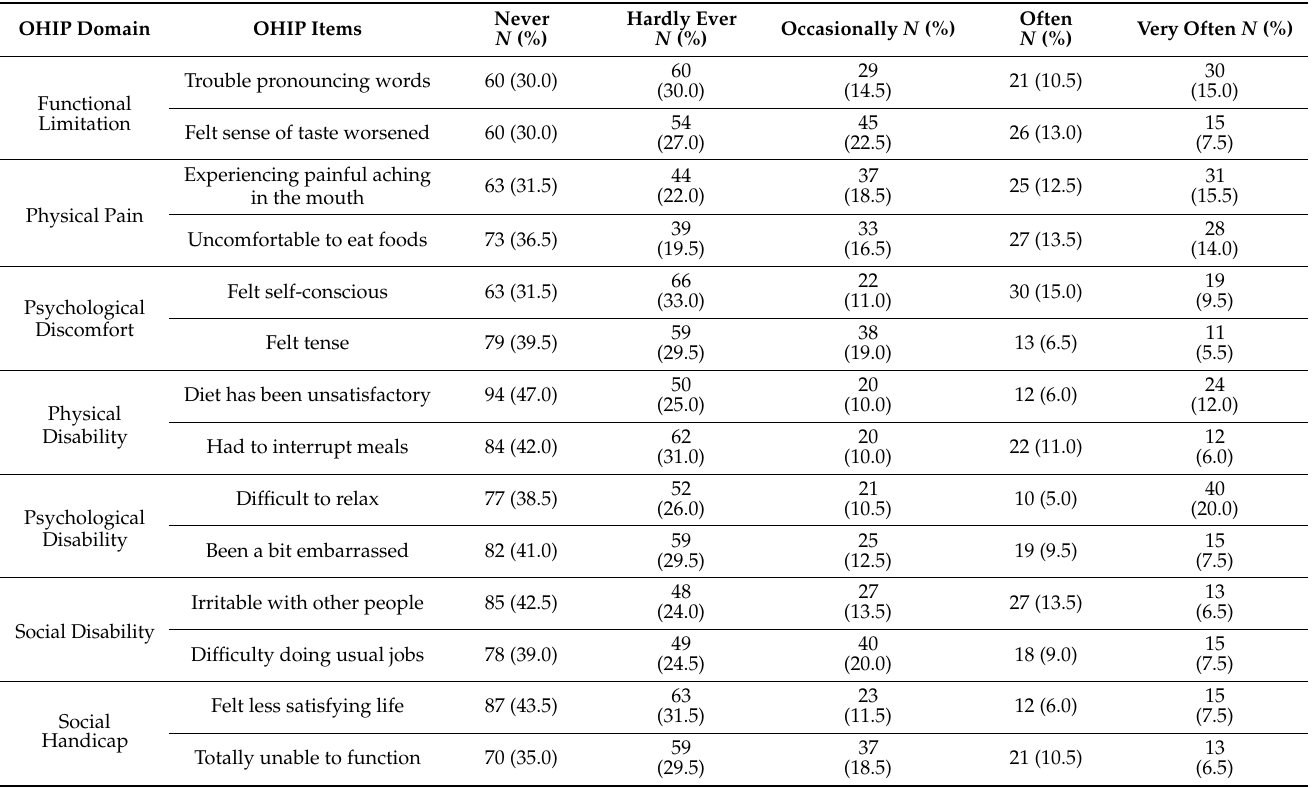
Table 2. Distribution of responses to the 14 OHIP items.